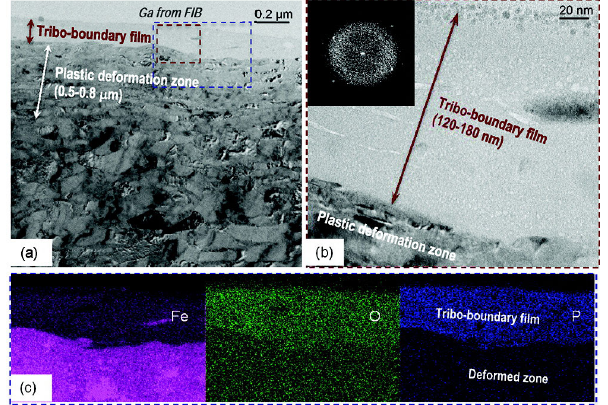
Fig. 15 TEM imaging and occurred EDS element mapping on the cross-section of the near surface zone of a cast iron worn surface lubricated by PAO+IL(5%). (b) and (c) correspond to the red dashed line box and blue dotted line box marked on (a), respectively. Reproduced with permission from Ref. [9].